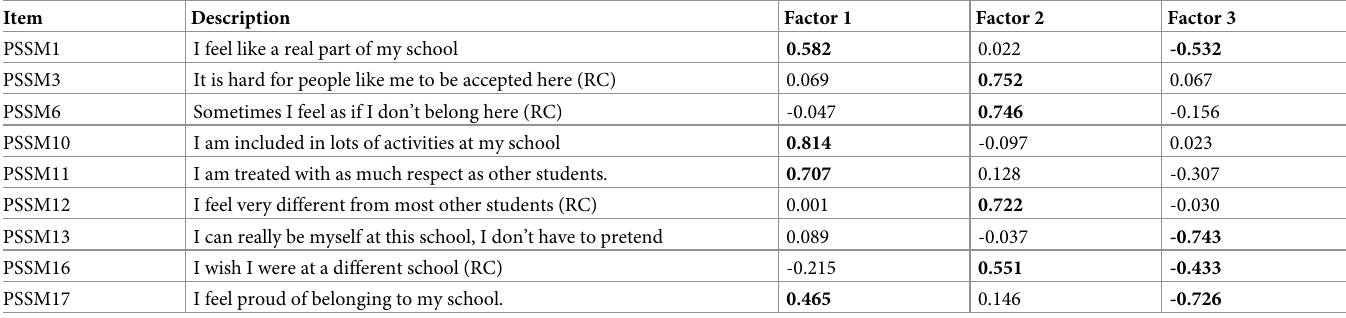
Table 2. Factor structure matrix of the three-factor